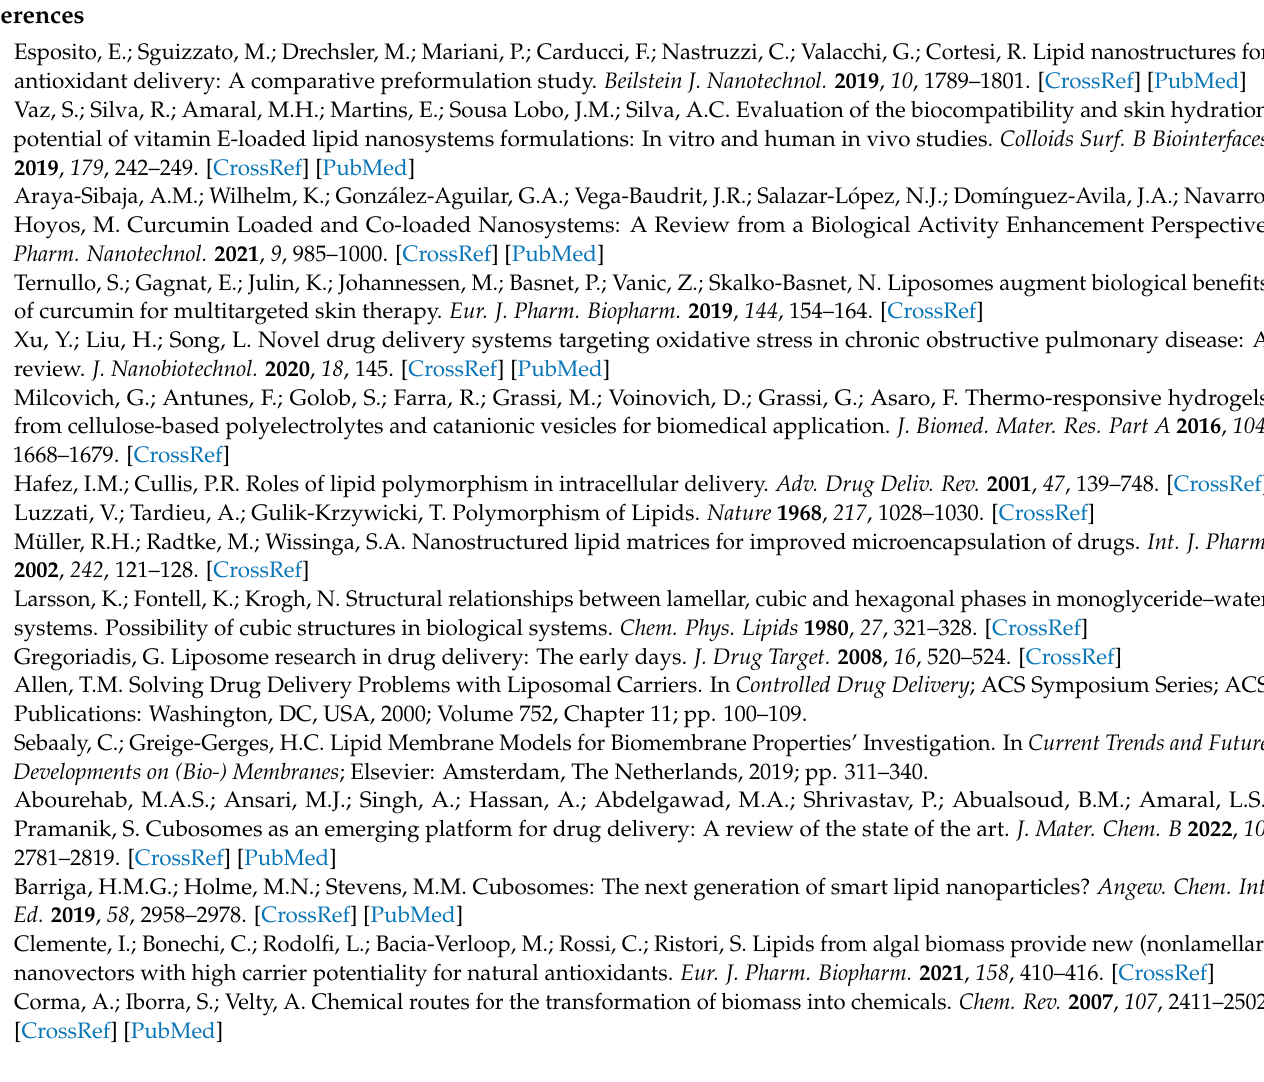
S3. Bar plot showing the Decr. % Abs ± standard deviation of relevant samples in either regular or disrupted state against EE%; Figure S4. Fibroblasts viability after 24 h of contact with different concentrations of E-lip and cubosome nanovectors both empty and loaded with the different test molecules. * Data are statistically different in comparison to negative control (complete culture medium) p < 0.01; Figure S5. Optical microscope images of NIH3T3 mouse fibroblasts after 24 h of contact with: (a) negative control (complete medium); (b) 0.1% v / v cubosome nanocarriers; (c) 0.1% v / v liposome nanocarriers; (d) after removing the liposome